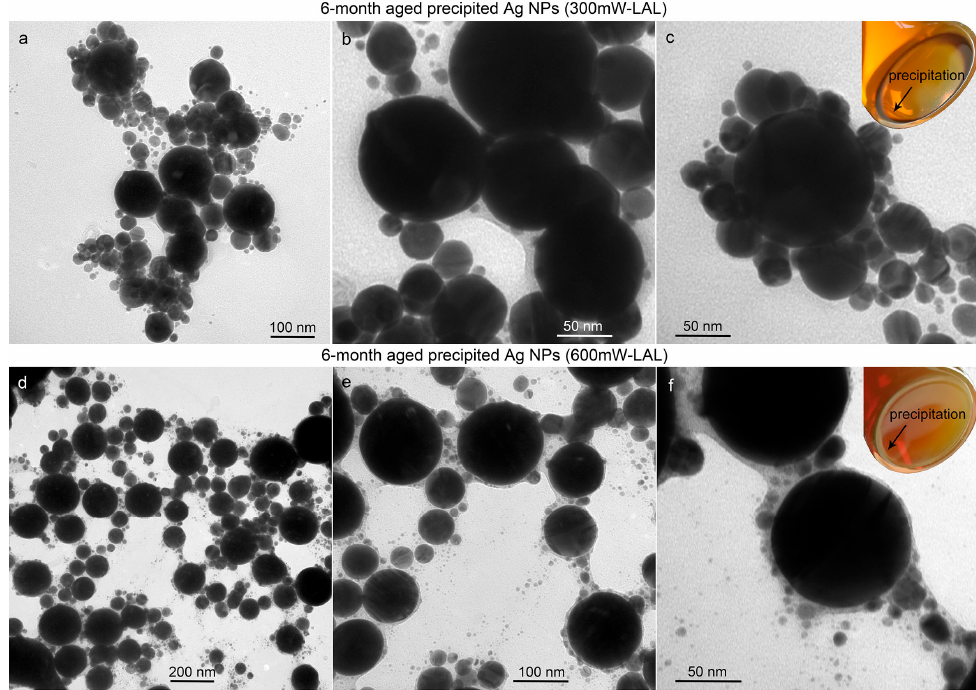
Figure 8. Precipitated particles after the six month storage of the Ag colloids, synthesized by femtosecond LAL at laser powers of ( a – c ) 300 mW and ( d – f ) 600 mW, respectively. The arrows shown in the optical images in the insets ( c , f ) indicate the particle precipitation after six months storage.